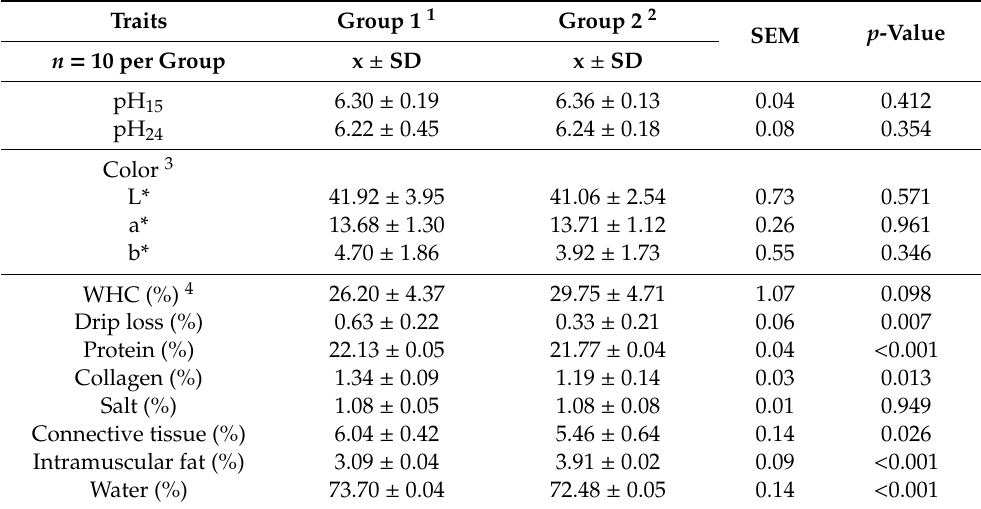
Table 6. Physicochemical parameters of breast muscles (means; ± SD; SEM) in 16-week-old geese. Traits Group 1 1